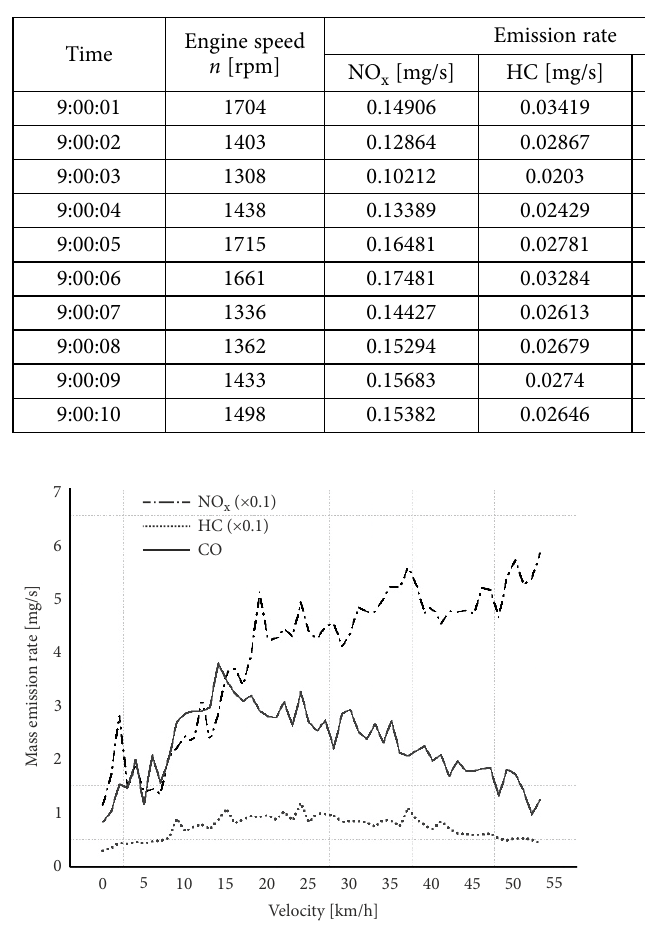
Figure 3. Changes in NO x , HC, and CO mass emission rates with velocity Table 3. Mass emission rates of NO x , HC, and CO under different velocity ranges